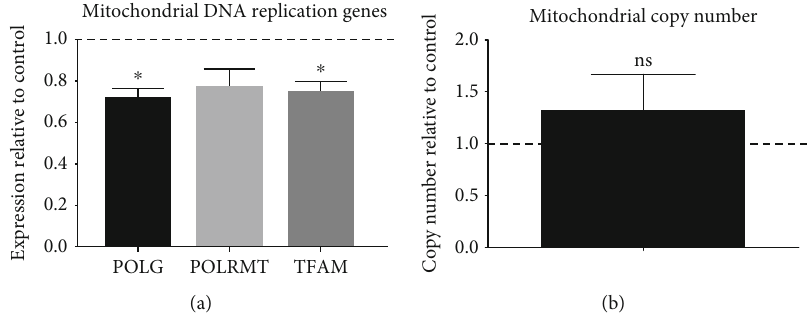
Figure 4: In AMD cybrids, hRPCs decrease the expression of mtDNA replication genes. (a) AMD cybrids cocultured with hRPCs showed signi fi cantly reduced expression of mtDNA replication genes. The AMD cybrids with hRPC treatment had lower expression levels of POLG ( 73 : 0 % ± 3 : 3 % , p = 0 : 015 ) and TFAM ( 72 : 8 % ± 3 : 0 % , p = 0 : 025 ), but not POLRMT ( 78 : 9 % ± 7 : 5 % , p = 0 : 107 ) compared to control and untreated AMD cybrids (assigned a value of 1, dotted line). (b) AMD cybrids treated with hRPCs did not show a signi fi cant di ff erence in mtDNA copy number compared to control AMD cybrids (copy number relative to control = 1 : 339 ± 0 : 329 , p = 0 : 361 ). Data between the treatment and control groups were analyzed for di ff erences by performing one-sample t -tests on the expression fold change values either from the fi ve cybrid lines for each gene ( n = 5 ) or for mitochondrial DNA copy number ( n = 5 ), comparing the values with a hypothetical value of